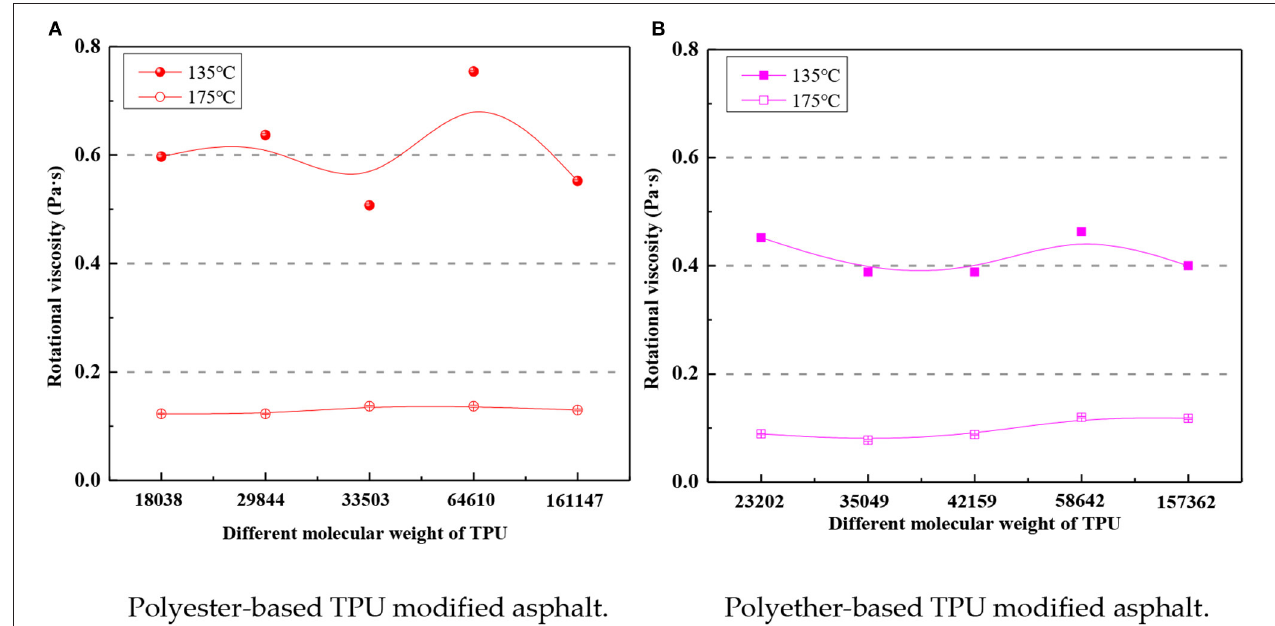
FIGURE 15 | Rotational viscosity. (A) Polyester-based TPU-modified asphalt. (B) Polyether-based TPU-modified